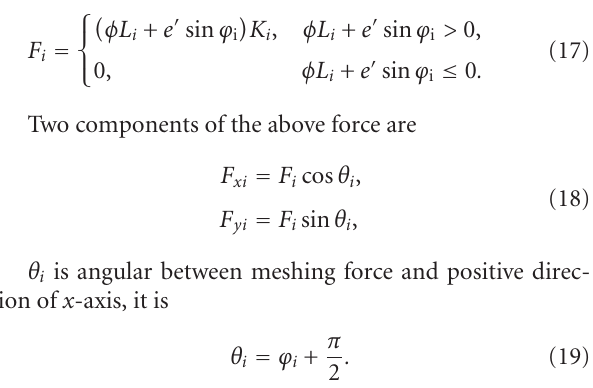
Figure 5: Meshing forces versus static